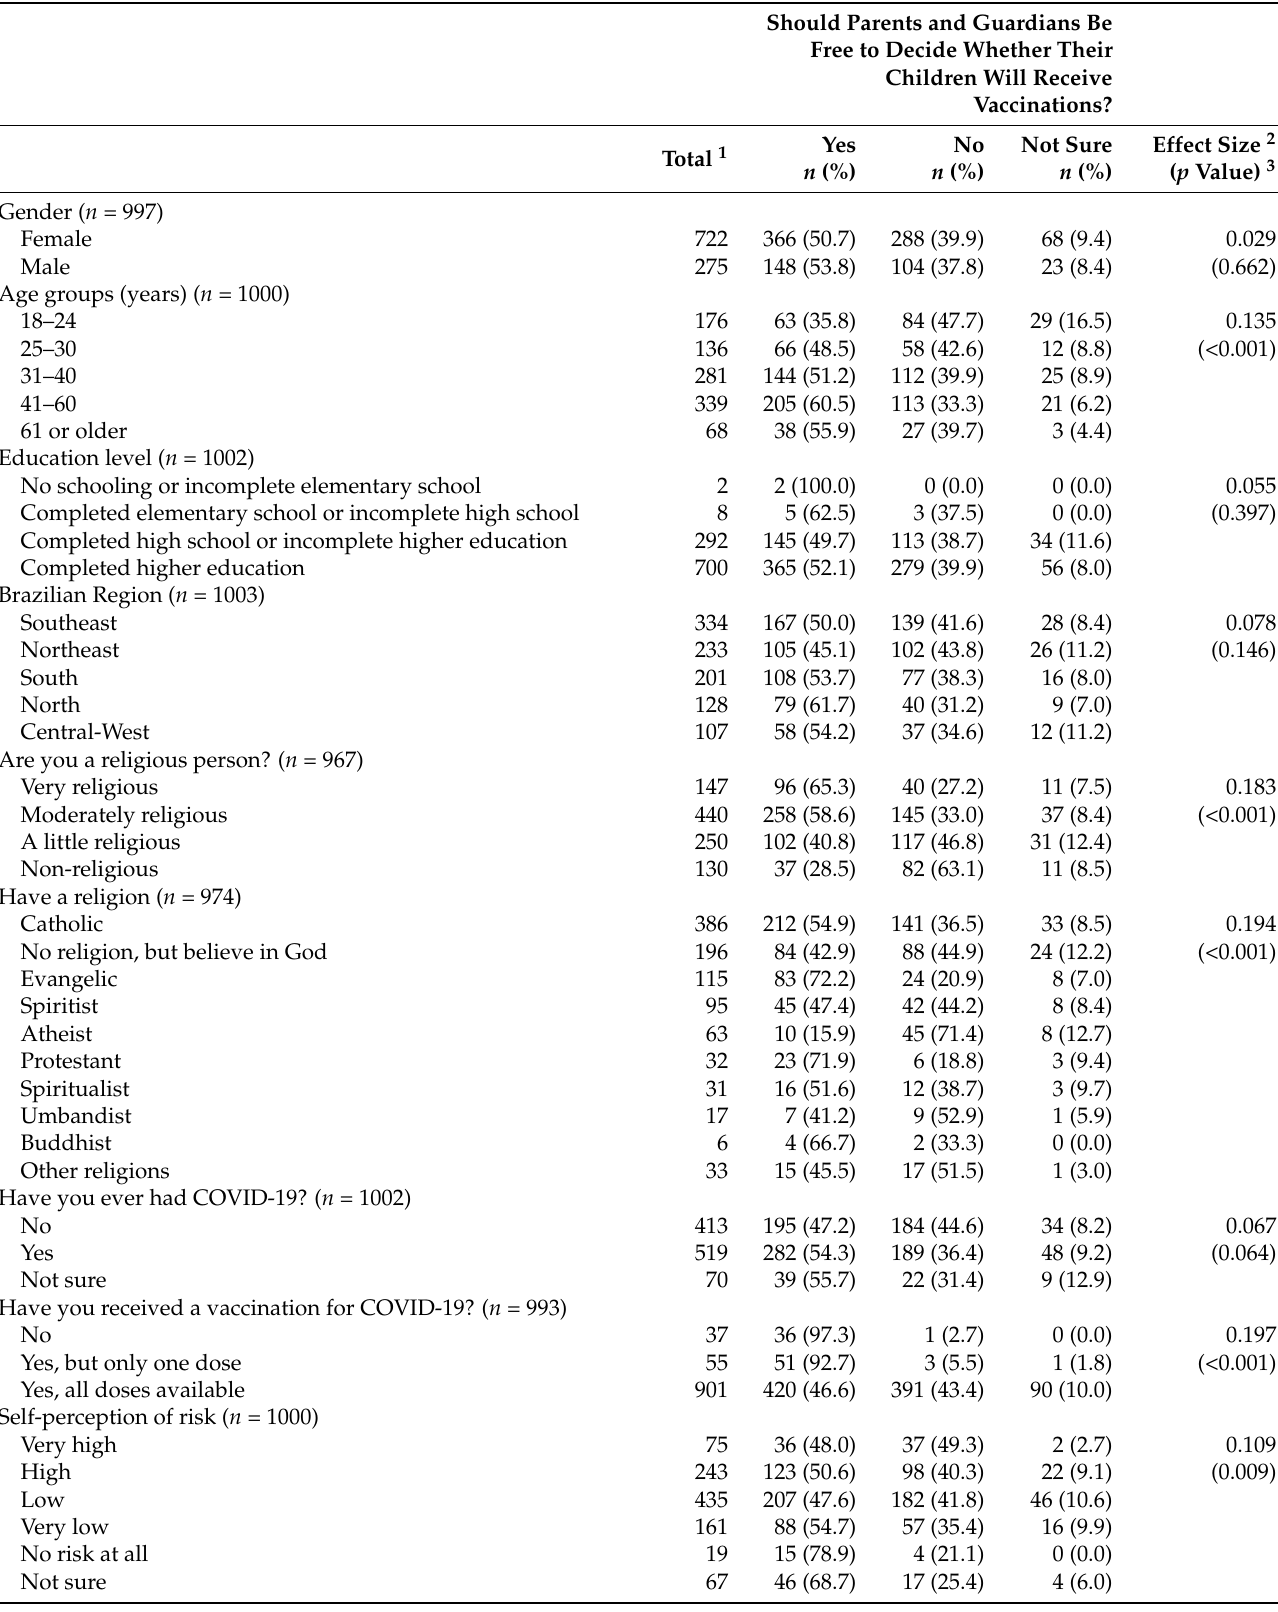
Table 3. Distribution of participants regarding their views on whether parents and guardians should be free to decide whether to have their children vaccinated against